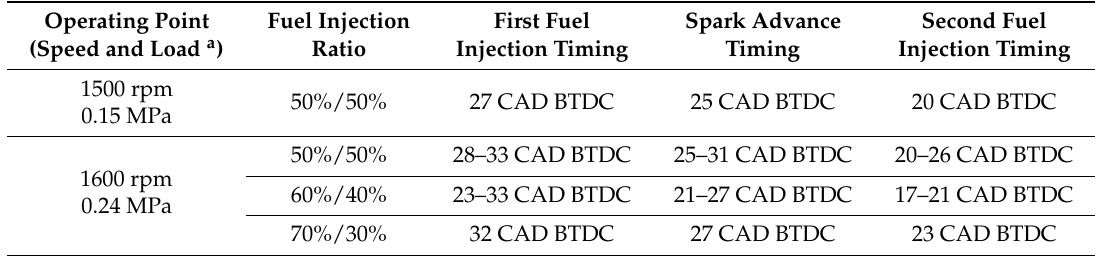
Table 2. Controlled combustion parameter for each operating